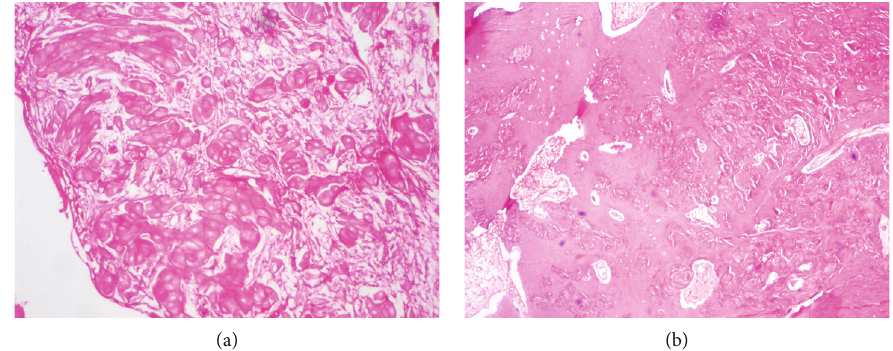
Figure 6: (a) A large number of nests and islands of ghost cells in the connective tissue stroma (H&E stain, × 40). (b) Ghost cells seen in large clusters in dysplastic dentin-inducted areas (H&E stain, × 100).